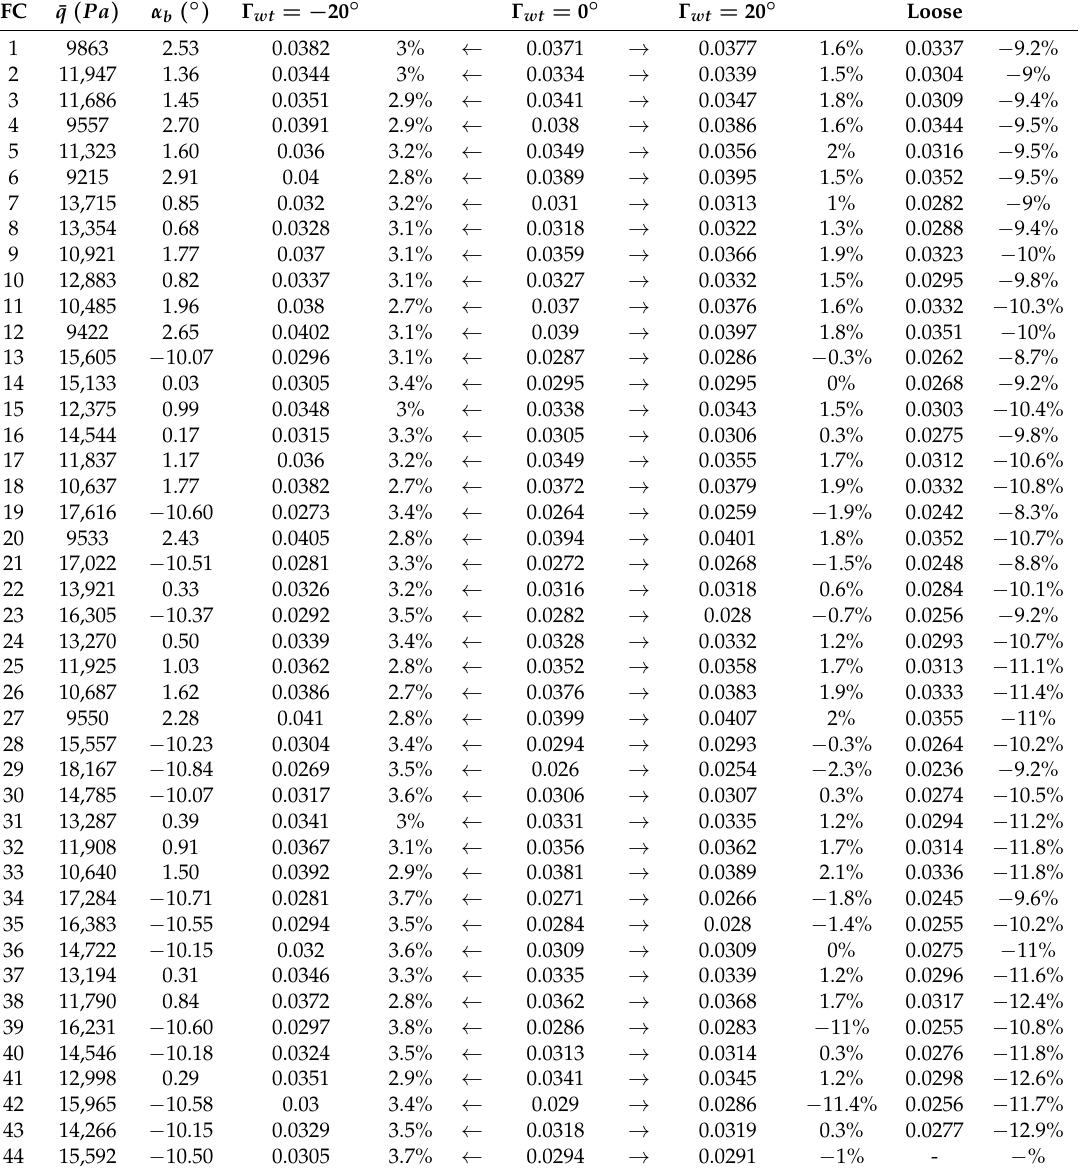
Table A6. C l Identification Results—20% Wingtip Flexible ξ